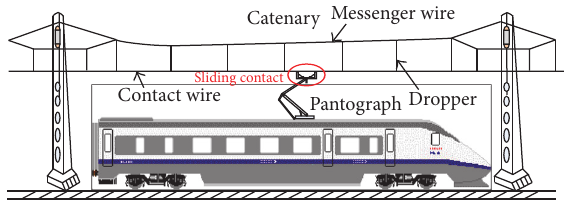
Figure 1: Schematic of the pantograph-catenary